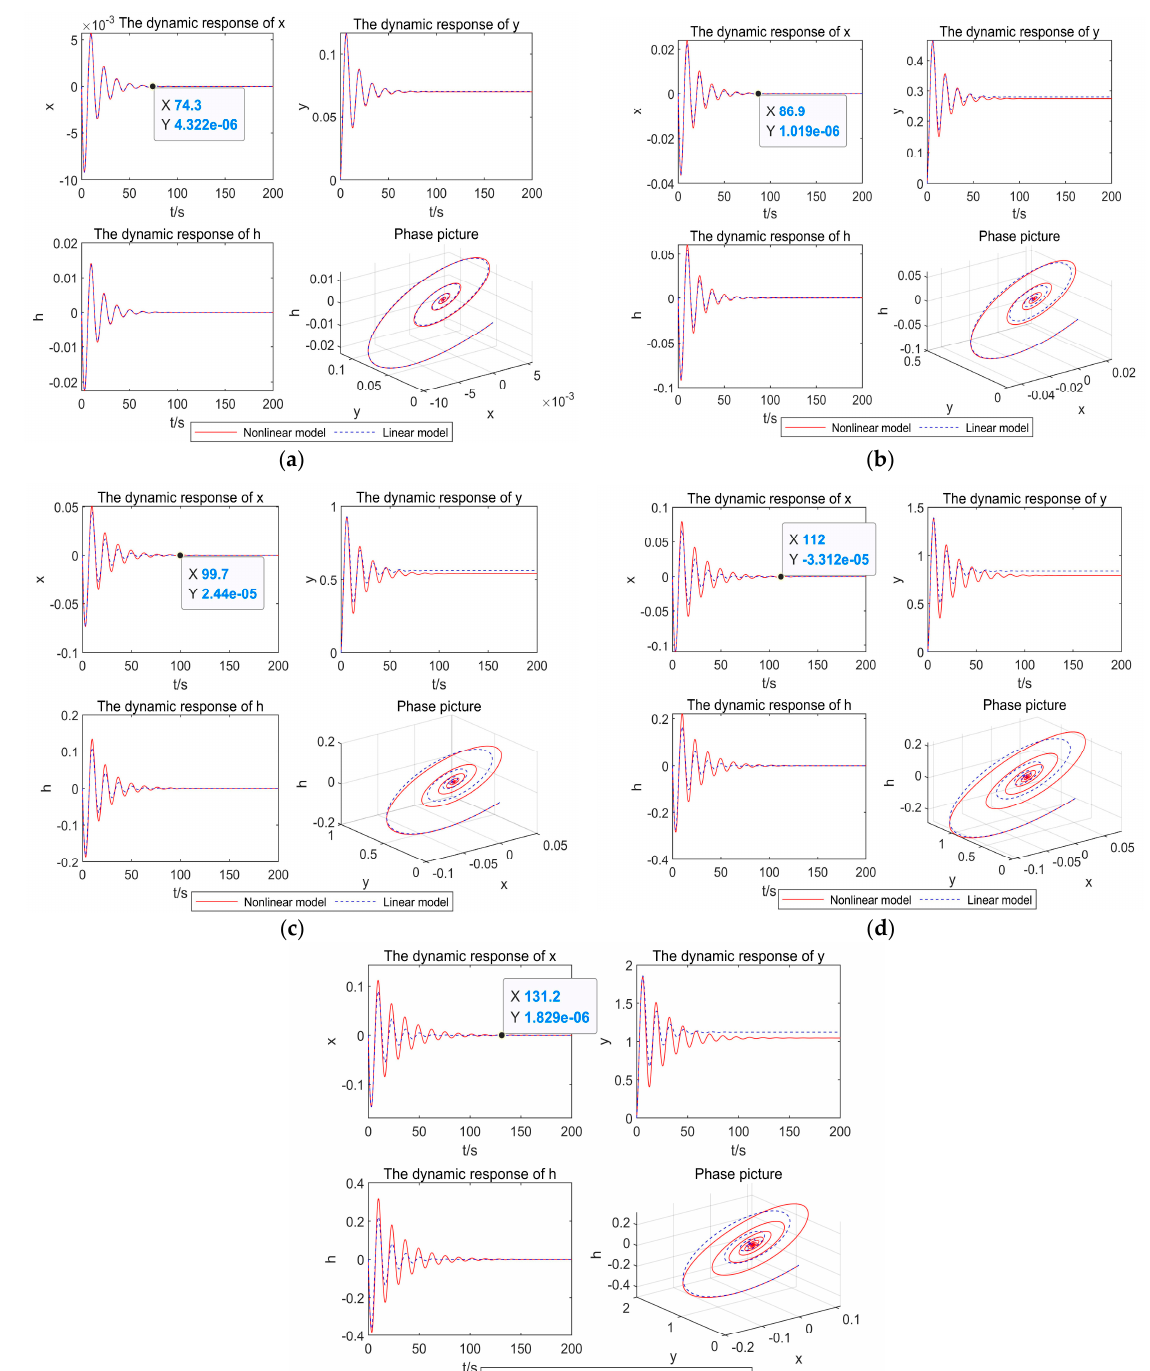
Figure 7. Dynamic response of linear and nonlinear models with load increasing: ( a ) 5%; ( b ) 20%; ( c ) 40%; ( d ) 60%; ( e ) 80%. ( c ) 40%; ( d ) 60%; ( e )